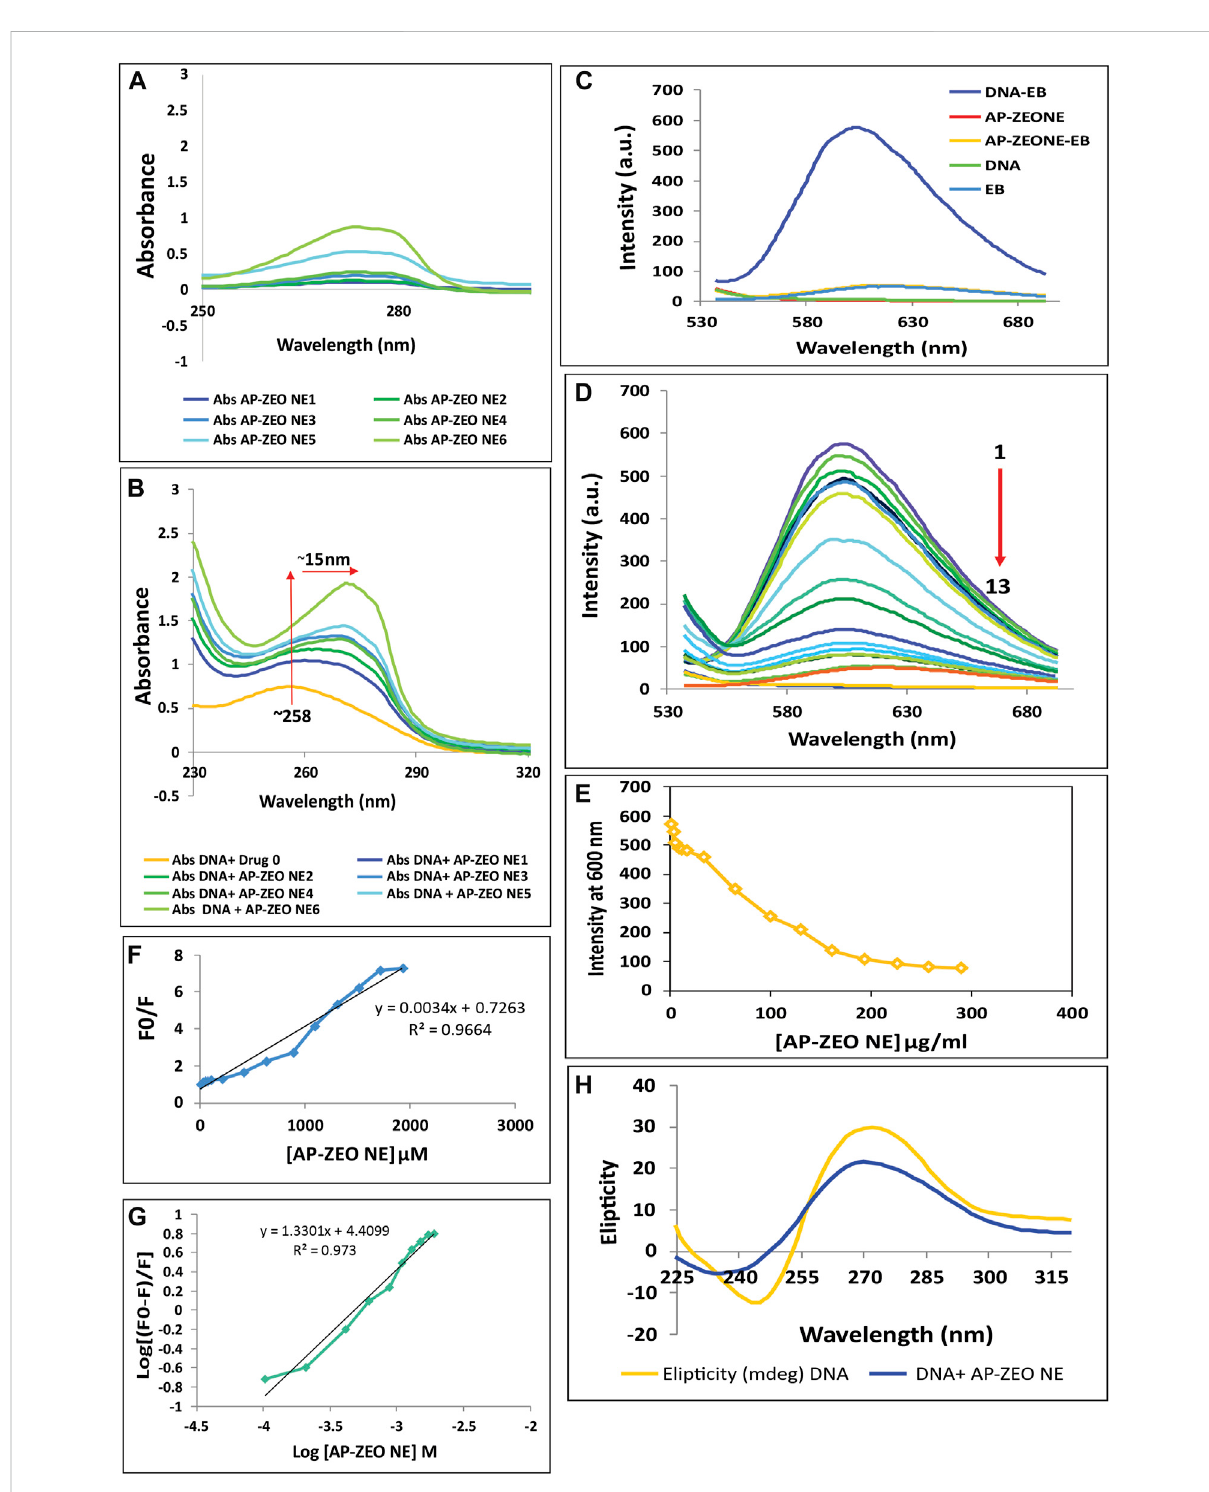
FIGURE 5 Interaction of AP-ZEONE with RH-DNA (A) UV – visible spectra of AP-ZEONE alone (B) and AP-ZEONE-DNA complex in the presence of AP- ZEONE(0 – 32 μ g/ml).Hyperchromismwitha15 nmshiftwasobservedwithanincreasingconcentrationofAP-ZEONE con fi rmingtheinteractionof AP-ZEONE and DNA (C) Fluorescence spectra of DNA, EB, AP-ZEONE, AP-ZEONE-EB, and DNA-EB. (D – E) Competitive displacement assays of DNA-EB in the presence of AP-ZEONE (0 – 192 μ g/ml). The arrow shows the decrease in the fl uorescence intensity upon increasing the concentration of AP-ZEONE (F) Fluorescence quenching Stern – Volmer plot of DNA-EB and (G) Modi fi ed Stern – Volmer plot for the quenching of DNA-EB with increasing concentration AP-ZEONE (H) The CD spectra of DNA (100 μ g/ml) in the presence of an 8 μ g/ml concentration of AP-